Question: In one sentence, what is this figure communicating?
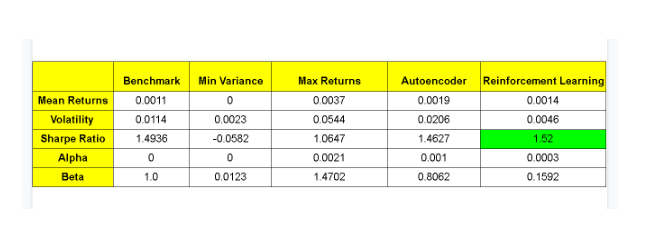
Answer: Comparison of RL with conventional portfolio management agents